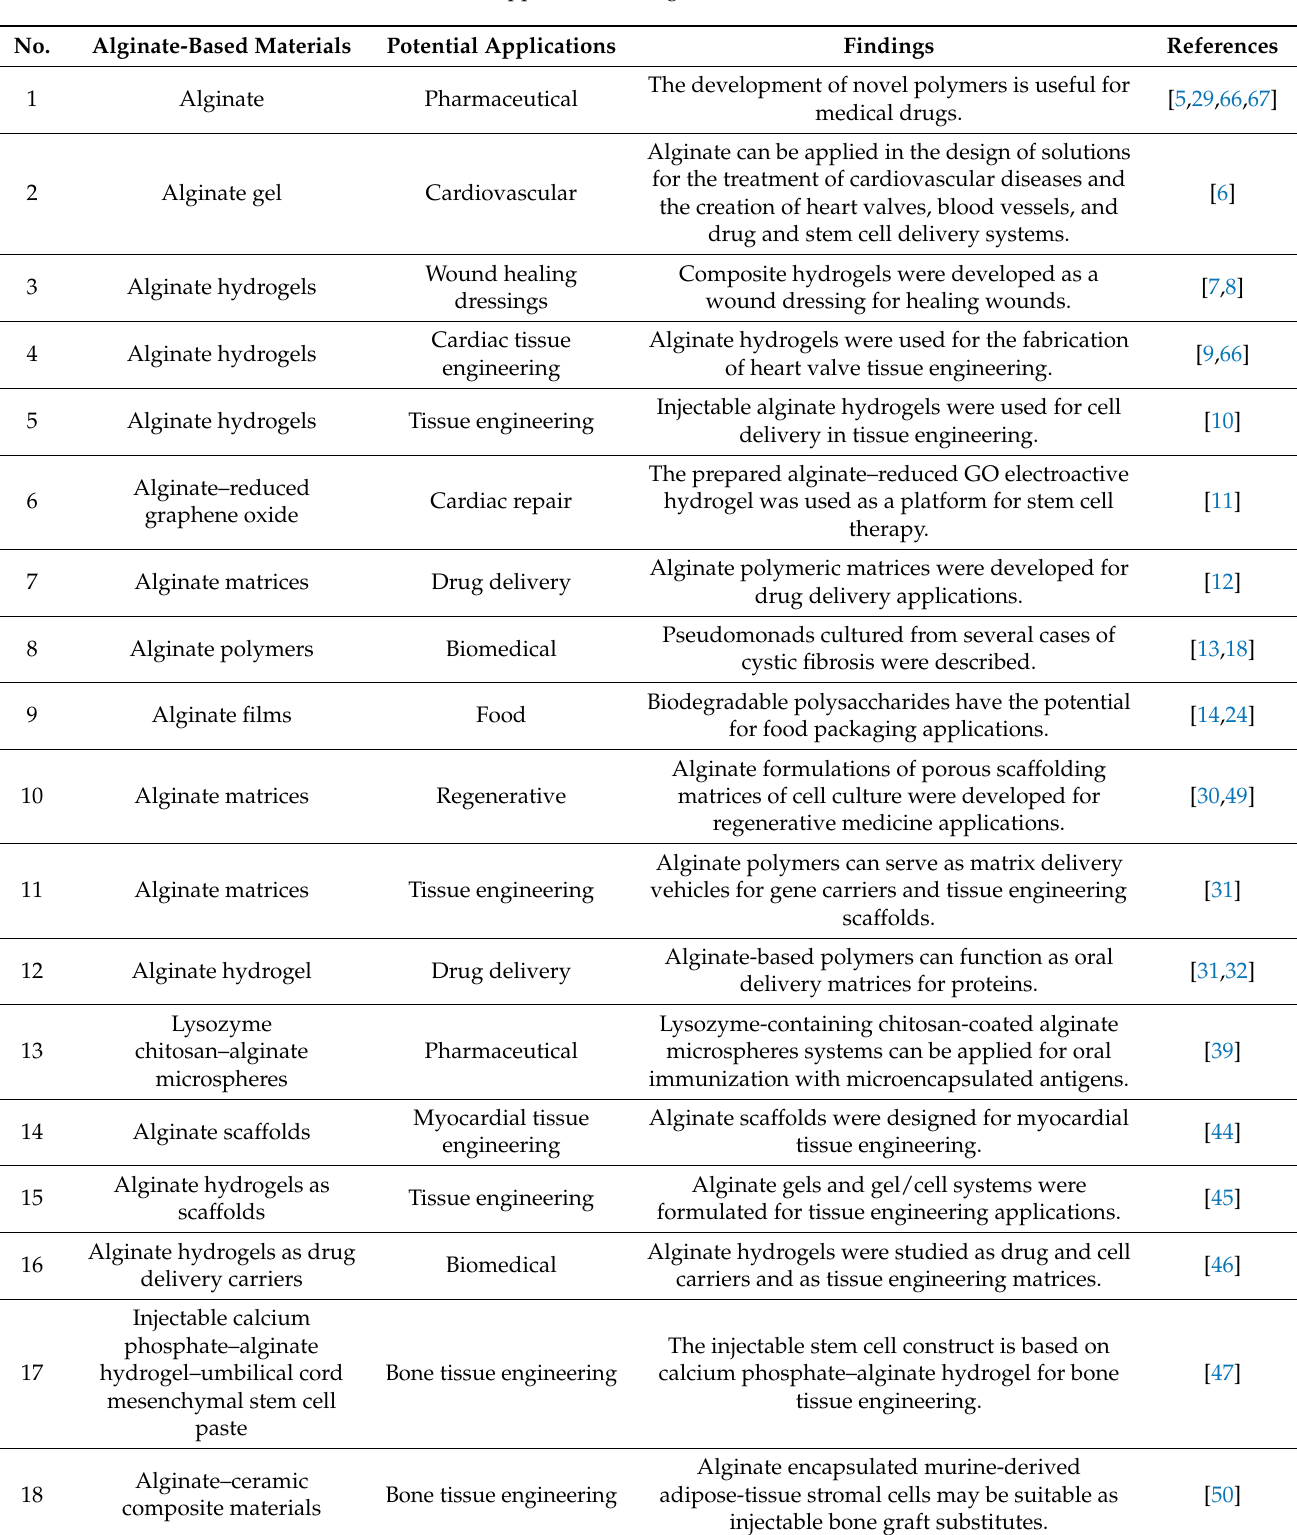
Table 1. Potential applications of alginate-based